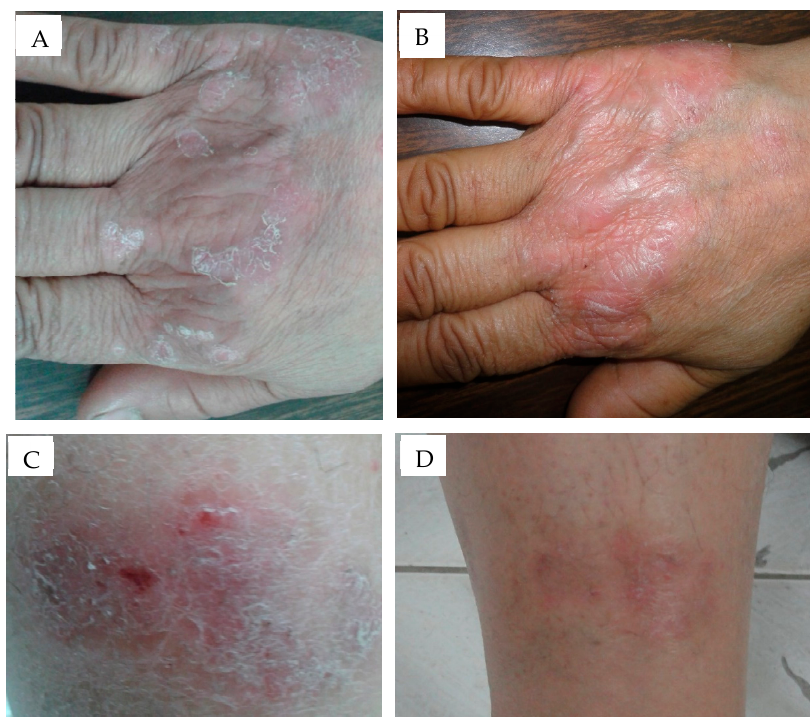
Figure 6. ( A ) A 44-year old male patient with a psoriasis vulgaris lesion on the dorsum of the right hand before treatment. ( B ) The same patient after 3 weeks of treatment with anthralin liposomal gel preparation showing marked improvement (Group I). ( C ) A 50-year old female patient with psoriasis vulgaris on the extensor surface of the right leg before treatment. ( D ) The same patient showing a marked improvement after 3 weeks of treatment with anthralin ethosomal gel preparation (Group II).